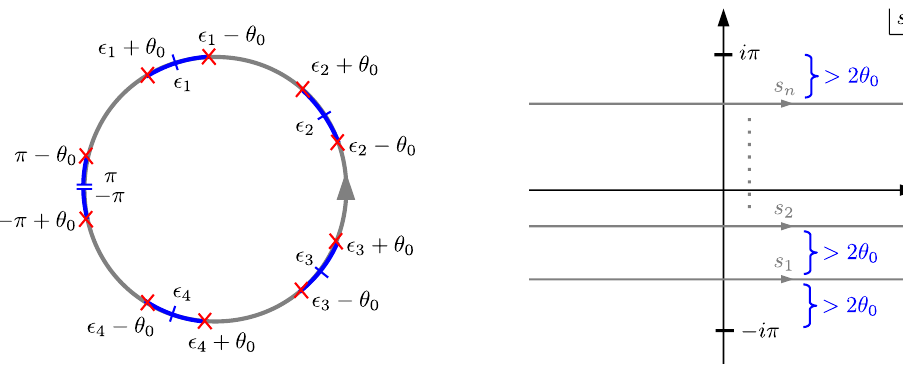
Figure 1 . Left: ordering of operators in (3.4). The red crosses are the Euclidean projections of the operator insertions, and the right ordering is achieved from the Euclidean time ordering by picking the s k integral contours in (3.4) accroding to (3.10). Right: illustration of the integration contours (grey) in (3.4) prescribed in